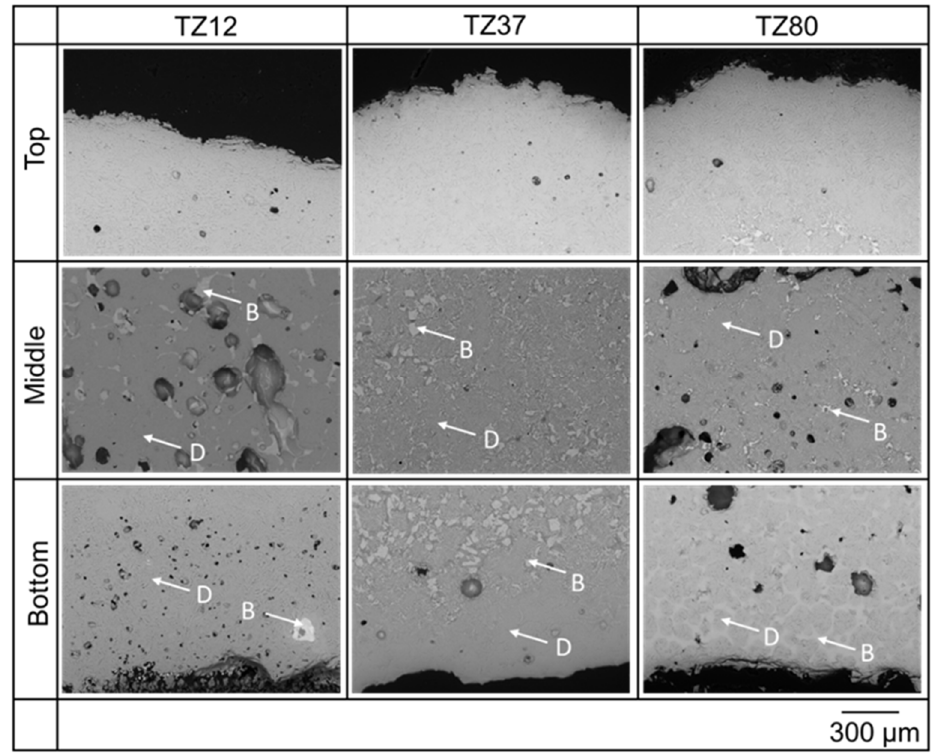
Figure 7. Enlarged BSE images obtained after infiltration into model preforms. The areas considered in Figure 7 are marked in Figure 4. Points B and D show brighter gray contrast and darker gray contrast, respectively.